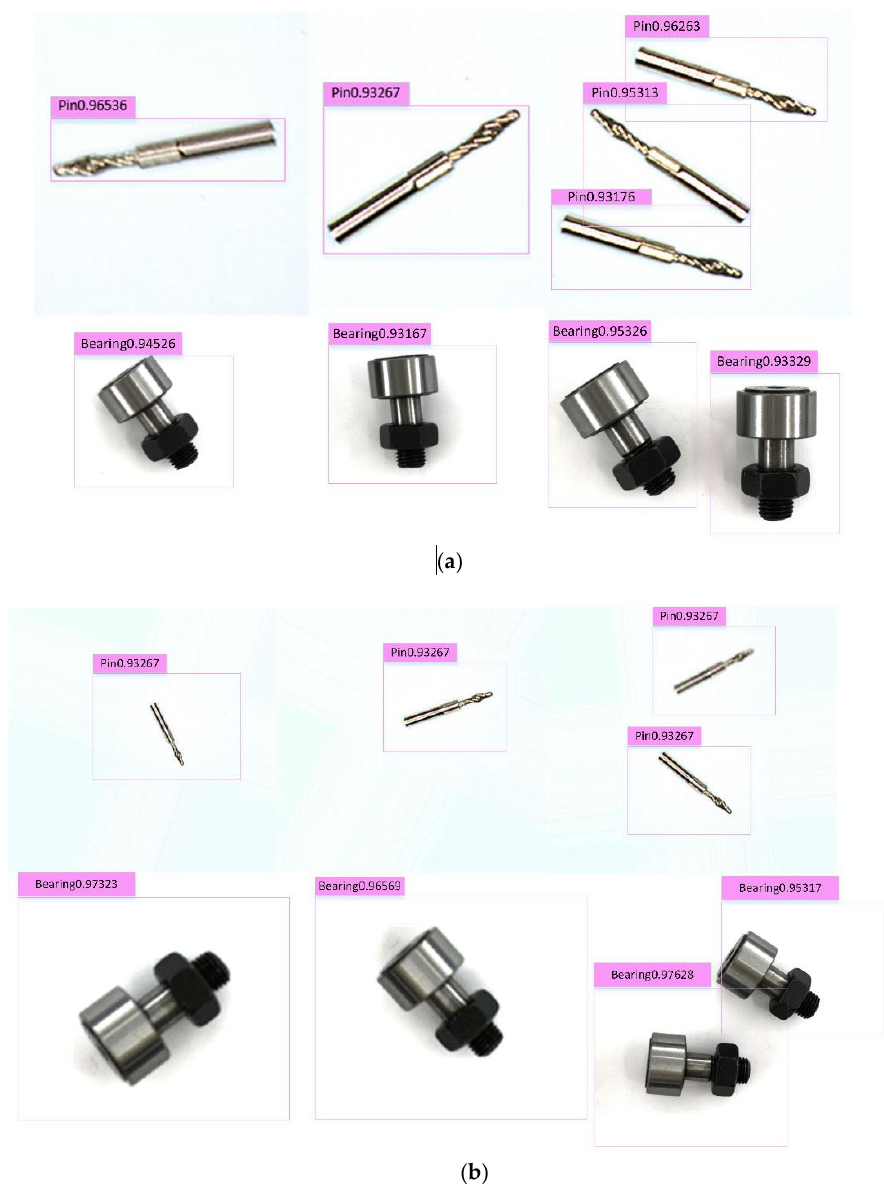
Figure 9. Example of resulting object recognition for subjective precision parts. ( a ) Example of resulting object recognition of mechanical parts for dataset A. ( b ) Example of resulting object recognition of mechanical parts for dataset B.